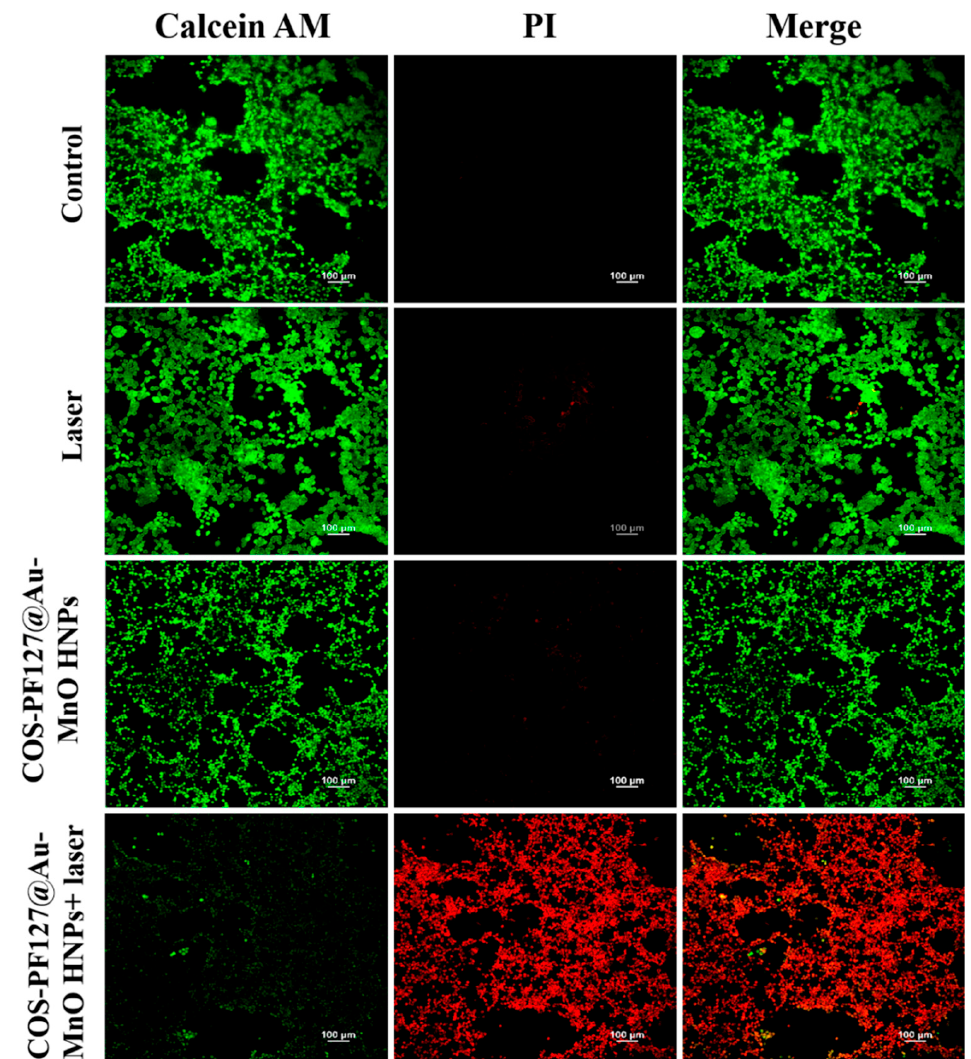
Figure 5. Fluorescent images of 4T1 cells stained with Live/Dead Double Stain Kit under different treatment groups such as PBS, laser, HNPs, and HNPs + laser. Green fluorescence indicates live cells which were stained by calcein-AM dye, red fluorescence indicates dead cells which were stained by propidium iodide (PI), and merge is the combined effect of live/dead cells. The scale bar is 100 μ m.